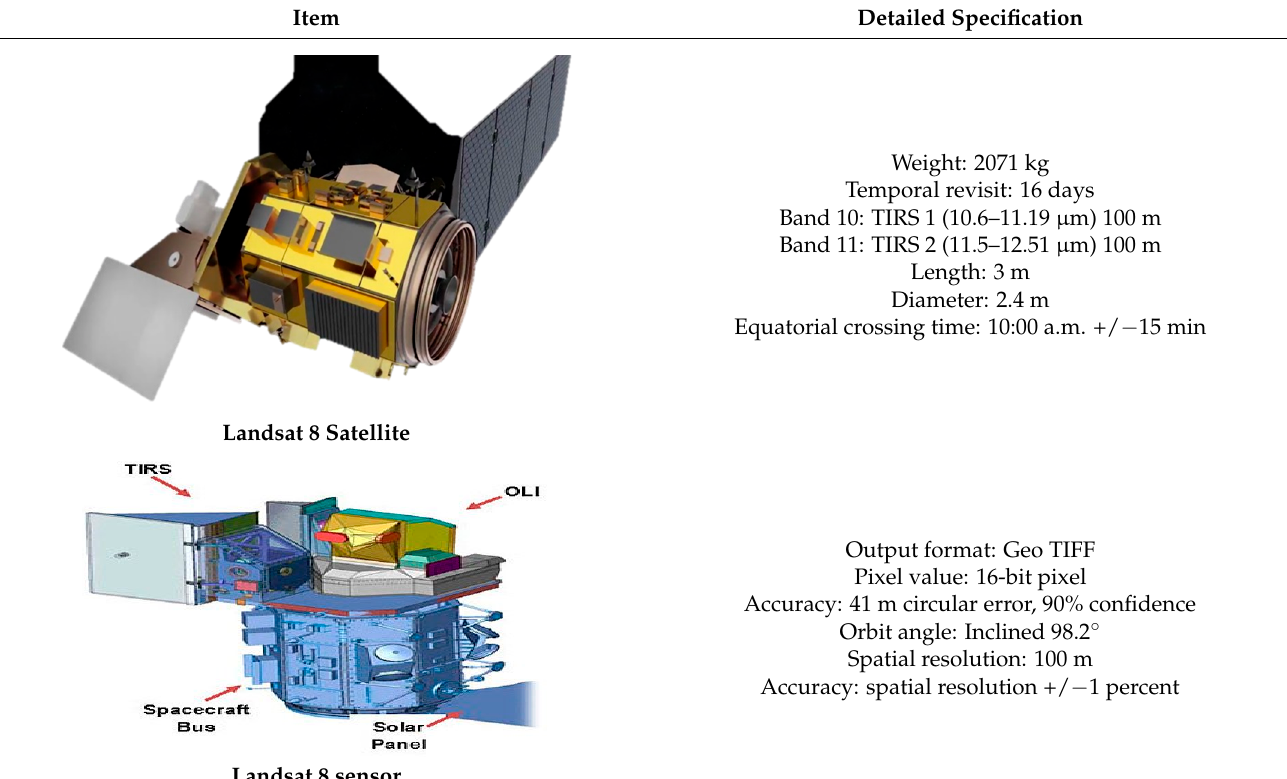
Table 3. The detailed specification of the Landsat 8 satellite and sensor. Item